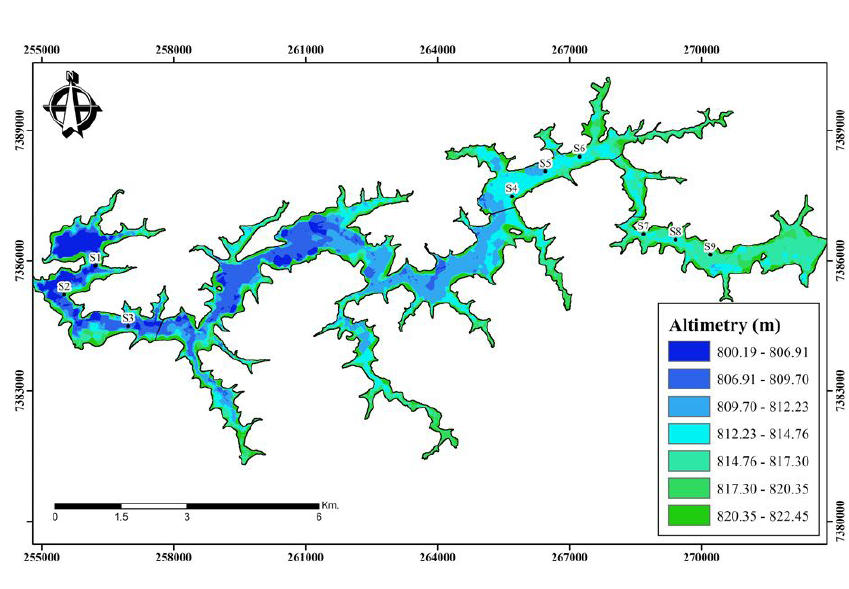
Figure 5. Altimetric map of Itupararanga reservoir, maximum depth: blue zones (800.19-806.91). The map shows the Itupararanga reservoir’s depth, in meters, in order to evaluate the relationship between the granulometric fractions and the depth at which the sampling collections were performed.